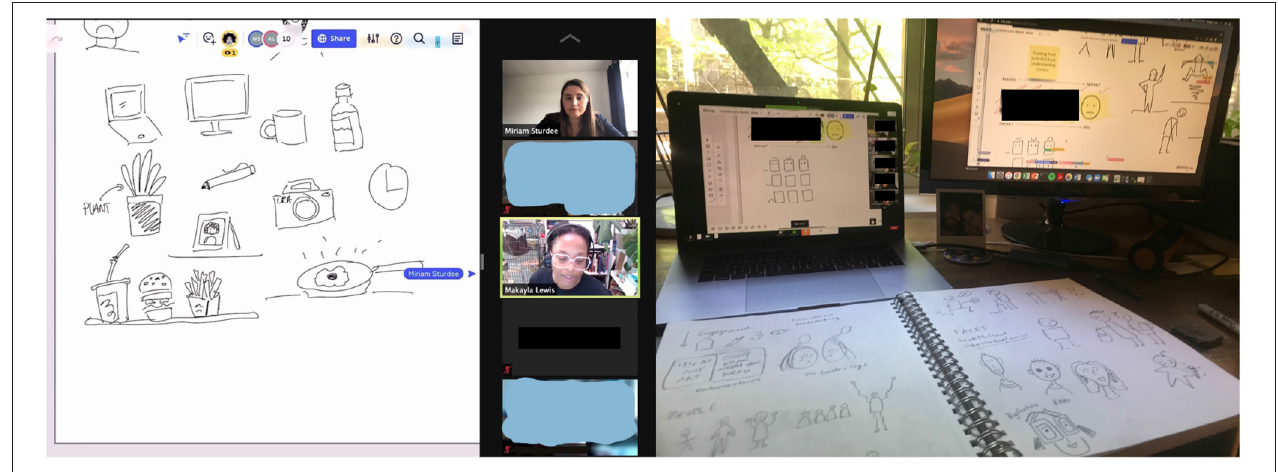
FIGURE 14 | (Left) ACM CHI 2021 delivery setup from student perspective. Andrés Lucero, 2021. (Right) ACM CHI 2021 delivery setup from student perspective. Maggie Jack,